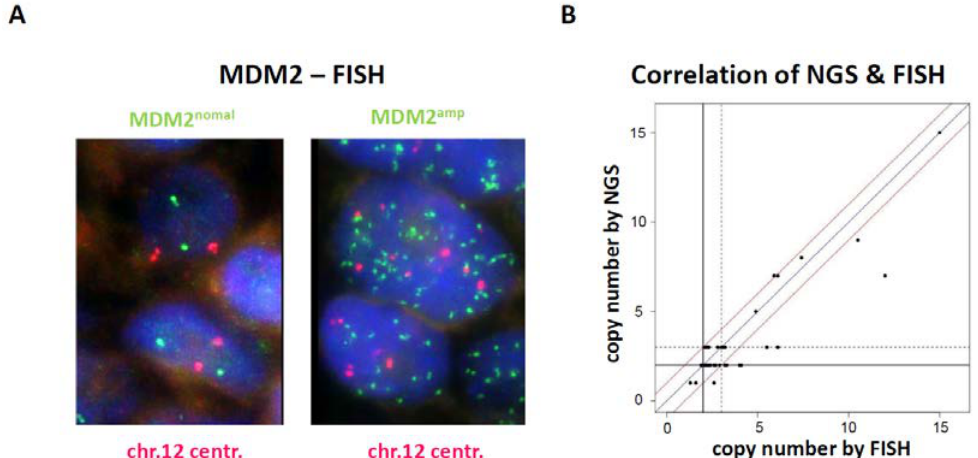
Figure 3. MDM2 fluorescence in-situ hybridization (FISH). ( A ) Left microphotograph shows a representative case without MDM2 amplification ( MDM2 normal ). On average, 2.7 copies of MDM2 per